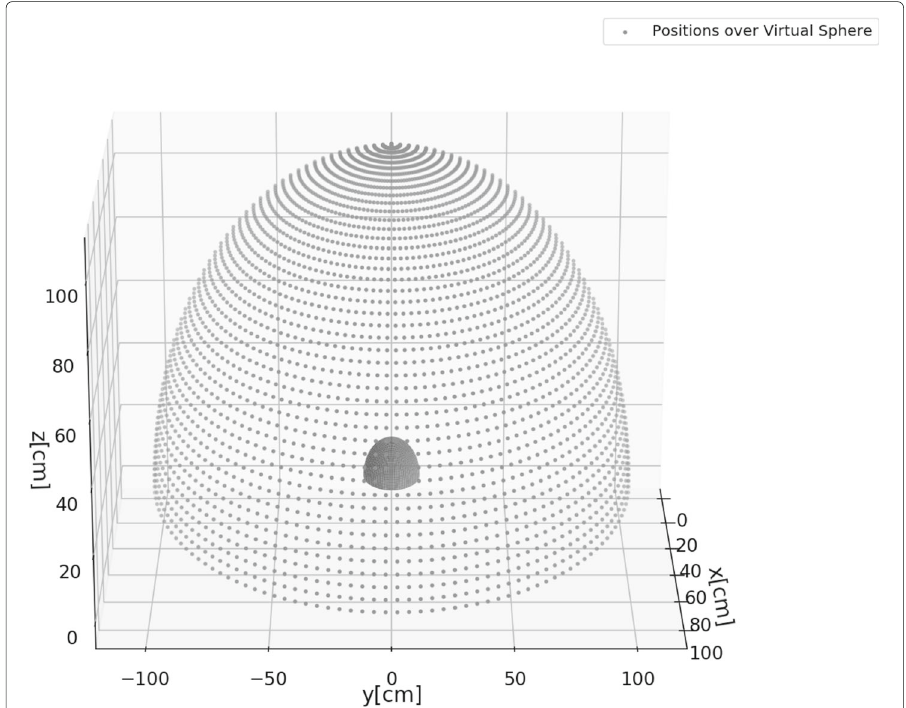
Fig. 4 Representation of the positions of the lamp over a virtual sphere of radius 102.5 cm. The AMUDIS input optics is centred in the middle of the virtual sphere (grey dome). The lamp is positioned on different positions using a 6-axis robotic arm